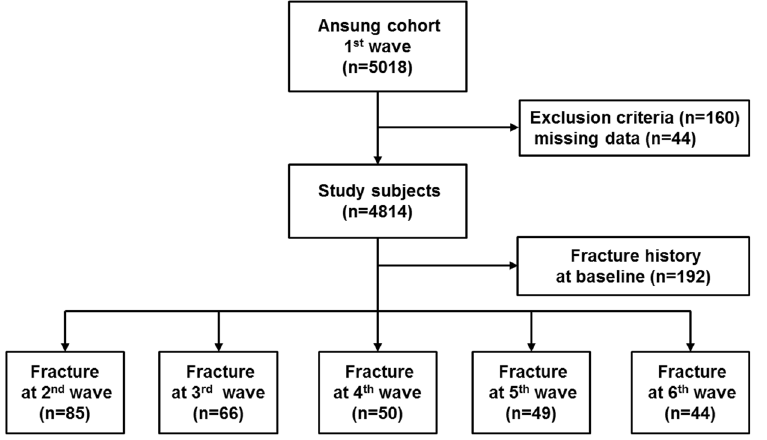
Figure 2. Flow diagram of study